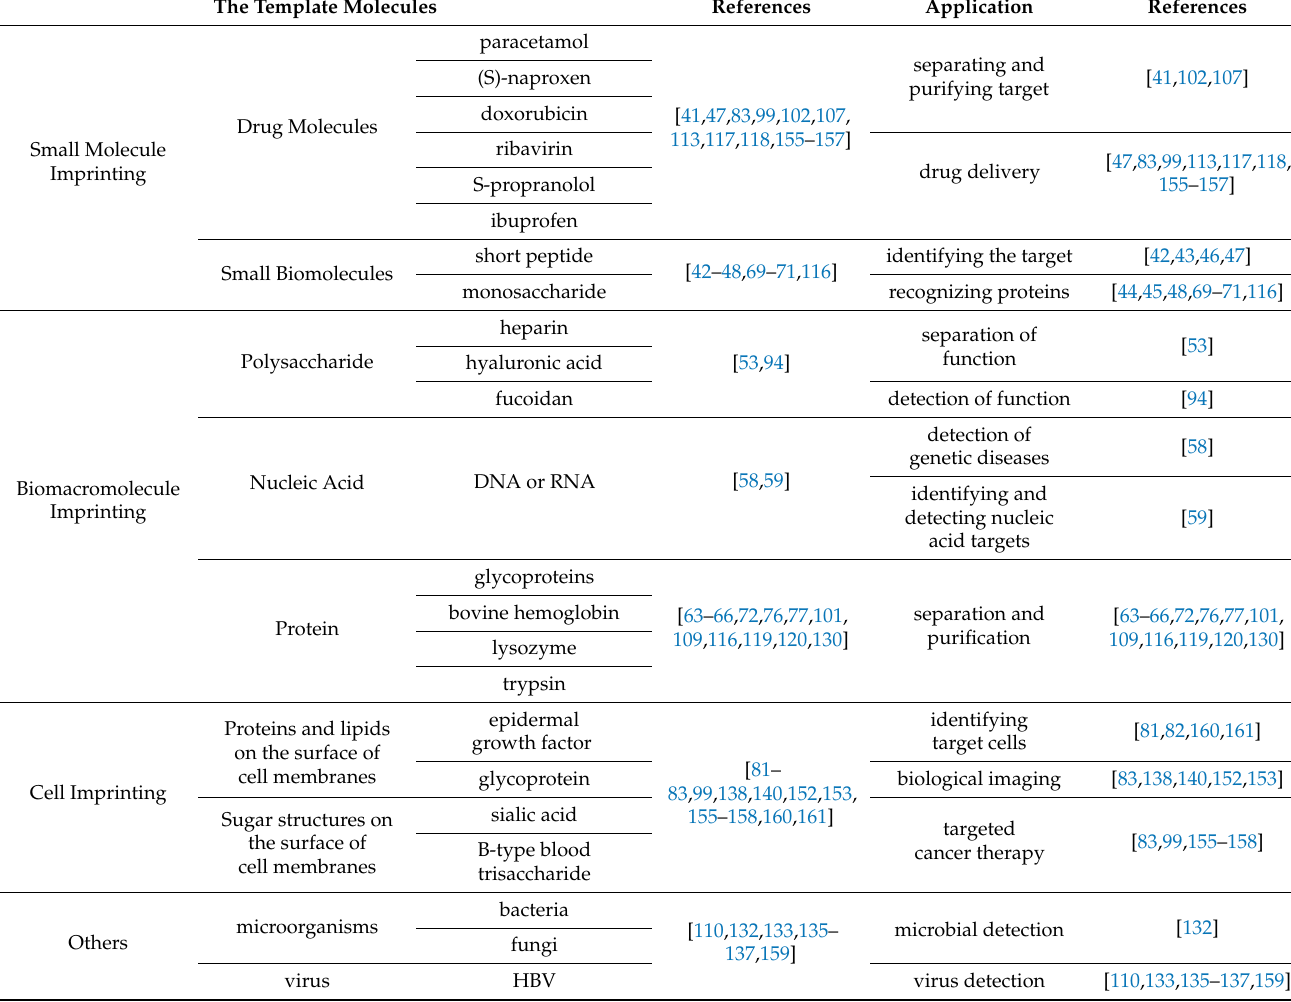
Table 1. Summary of references with different template molecules and corresponding applications. The Template